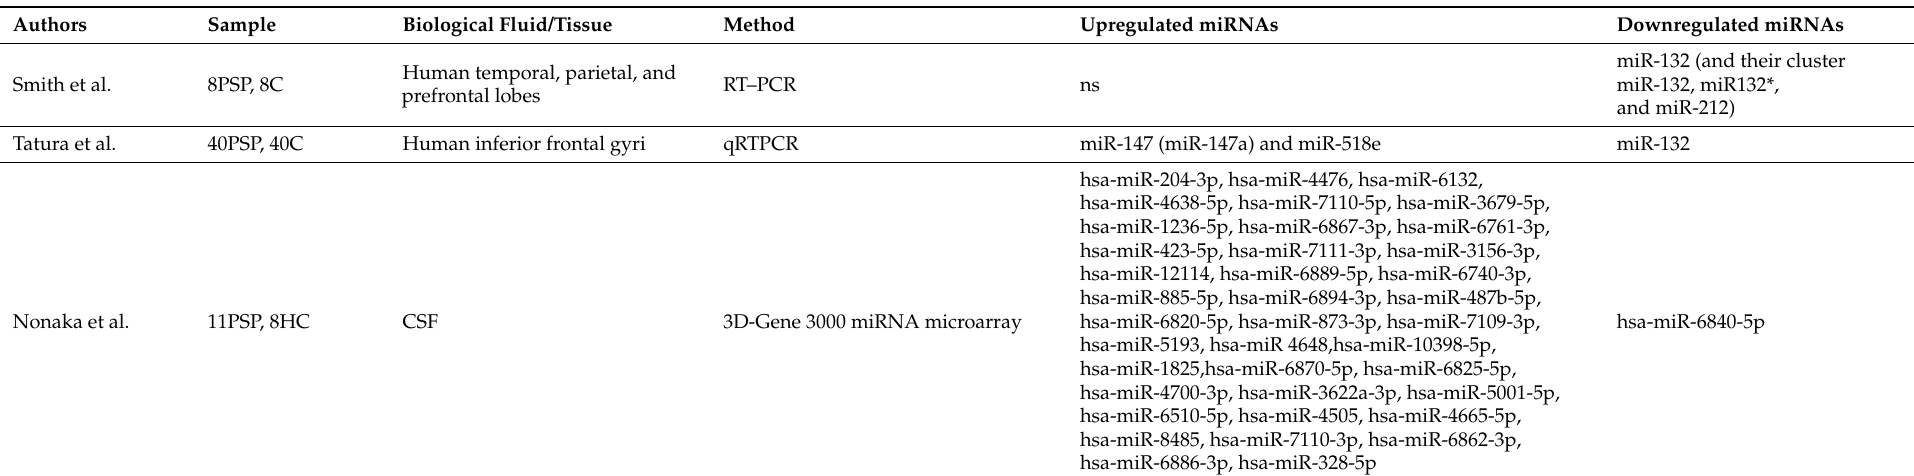
Table 2. Overview of microRNAs in PSP patients and animal